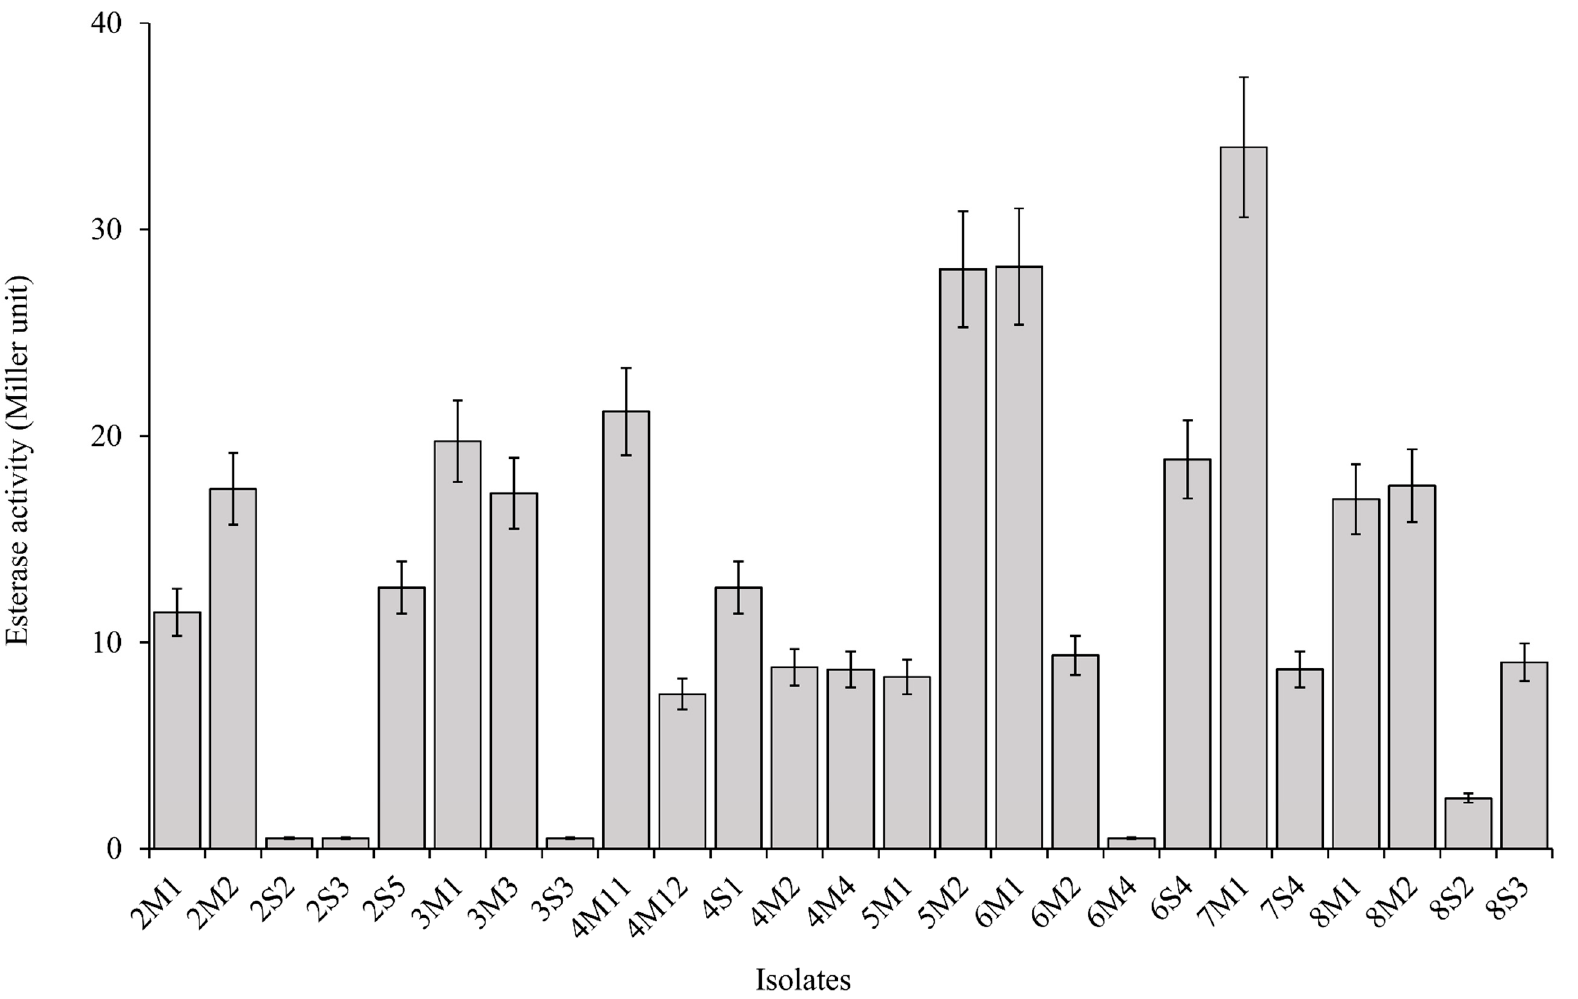
Figure 3. Carboxylesterase activity of LAB isolates based on Miller protocol. Error bar indicated standard error.